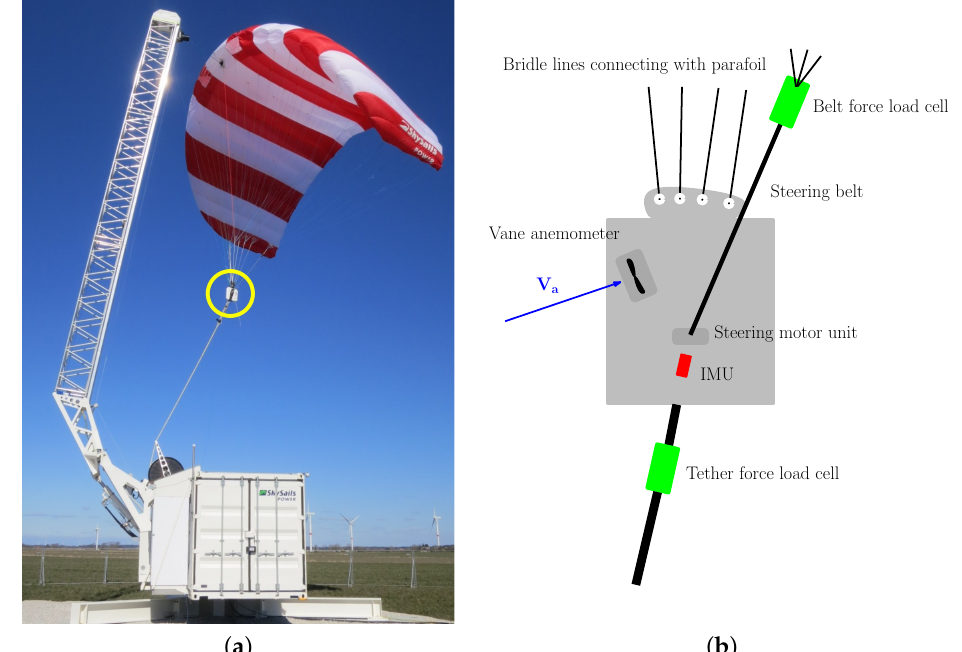
Figure 5. SkySails Power system SKS PN-14 and the sensor setup as adapted from [20]. ( a ) Ground station with the kite at mast during takeoff. The control pod (encircled) provides the system with several sensor data points. ( b ) Sketch of the control pod indicating force and apparent wind sensors and the position of the IMU. The belt force is measured to the left and right of the